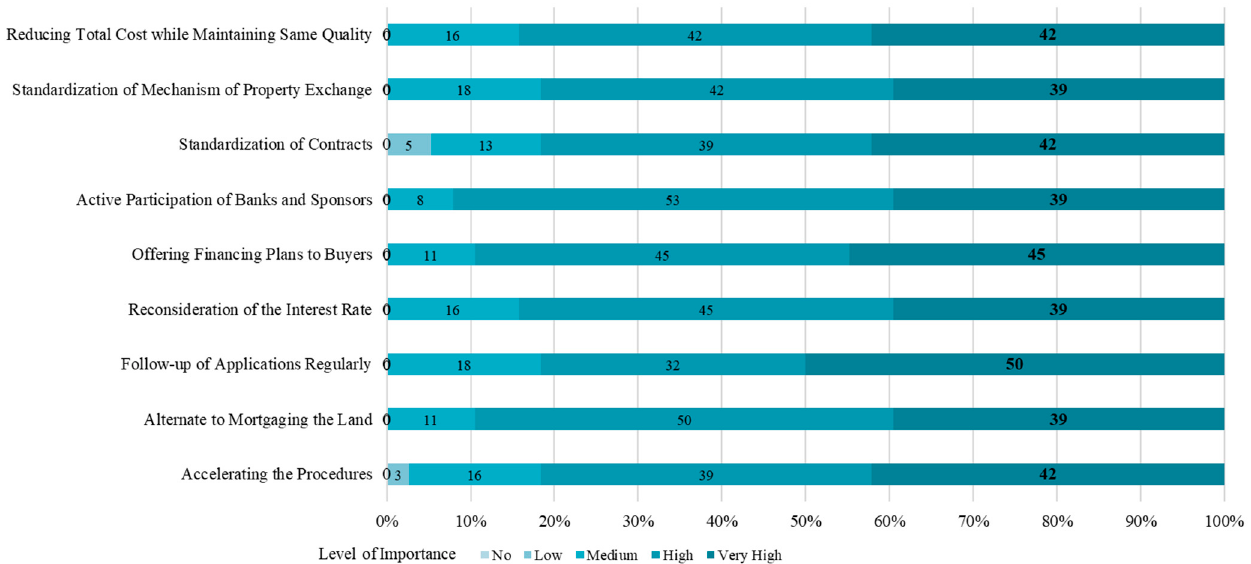
Figure 10. Response Percentage for each Proposed Financial Measure.